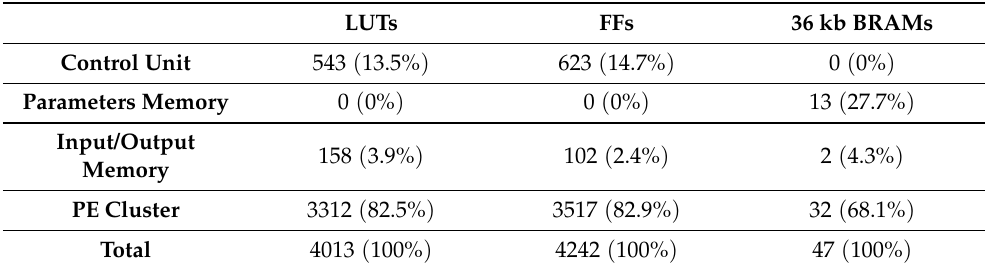
Table 12. ECG-ID-BNet IP core FPGA resource utilization.